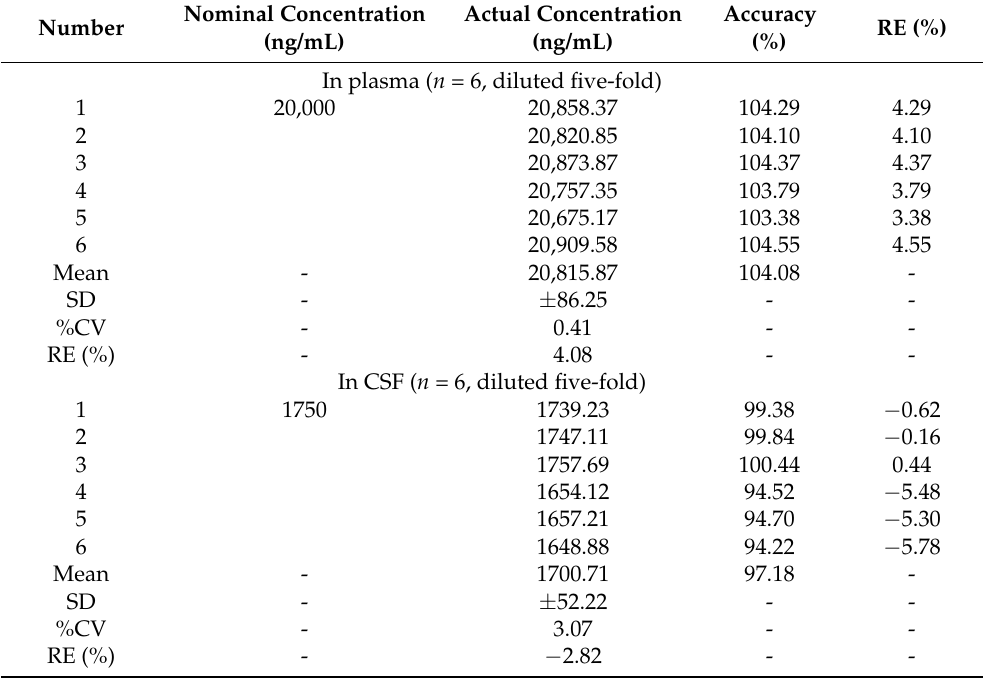
Table 3. Dilution integrity of the method for determining